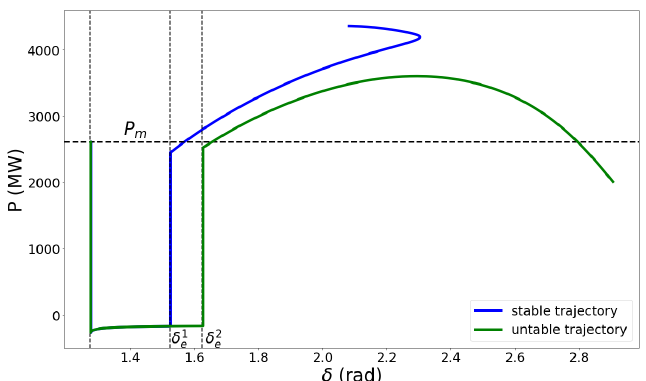
Figure 6. Dependence of post-fault OMIB power on t e . The δ − P curves are not necessarily